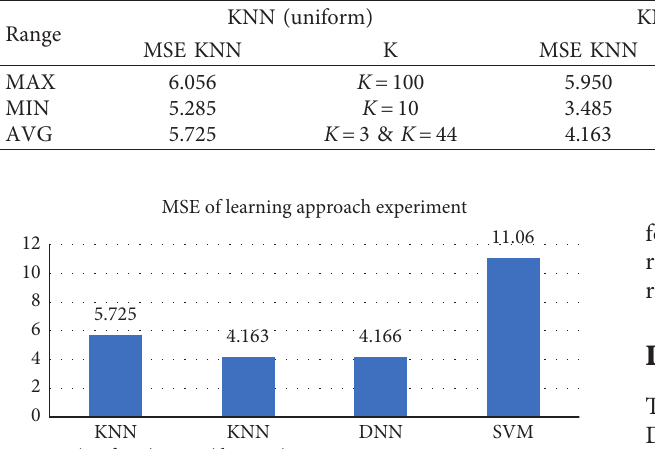
Table 9: The details of range values in learning approach experiments.